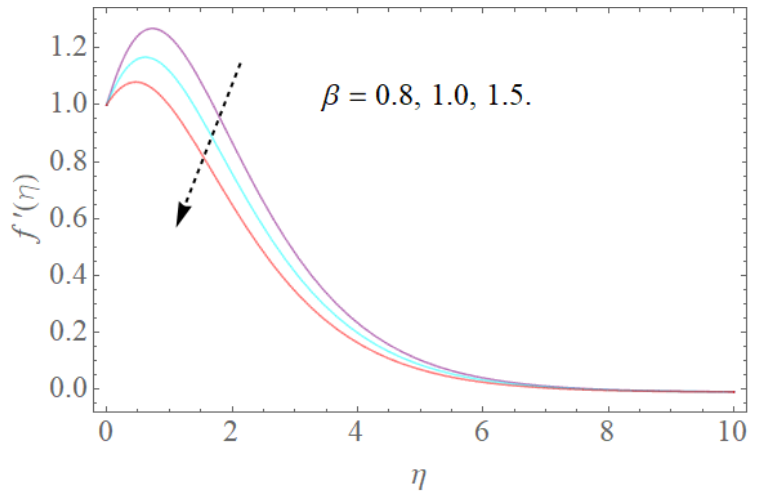
  f  Figure 2. The effect of β on f (cid:48) ( η ) when k 1 = 0.3, K = 0.7, R b = 0.4, N r = 2.0, λ = 1.1. Figure 2. The effect of  on when Table 2. Adapted frameworks and thermophysical properties for the hybrid